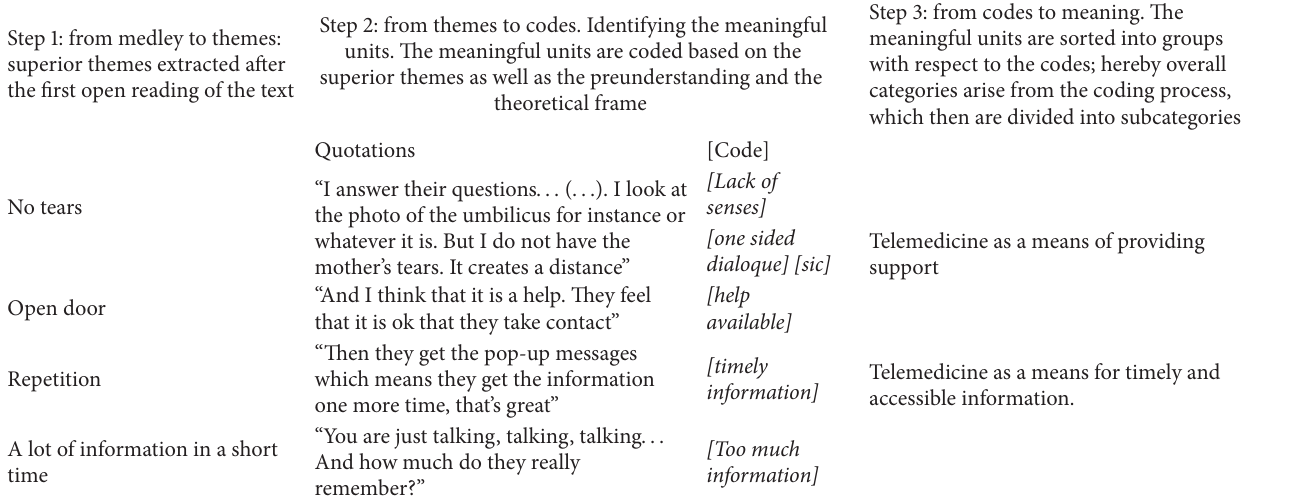
Table 1: Process of analysis, examples from the